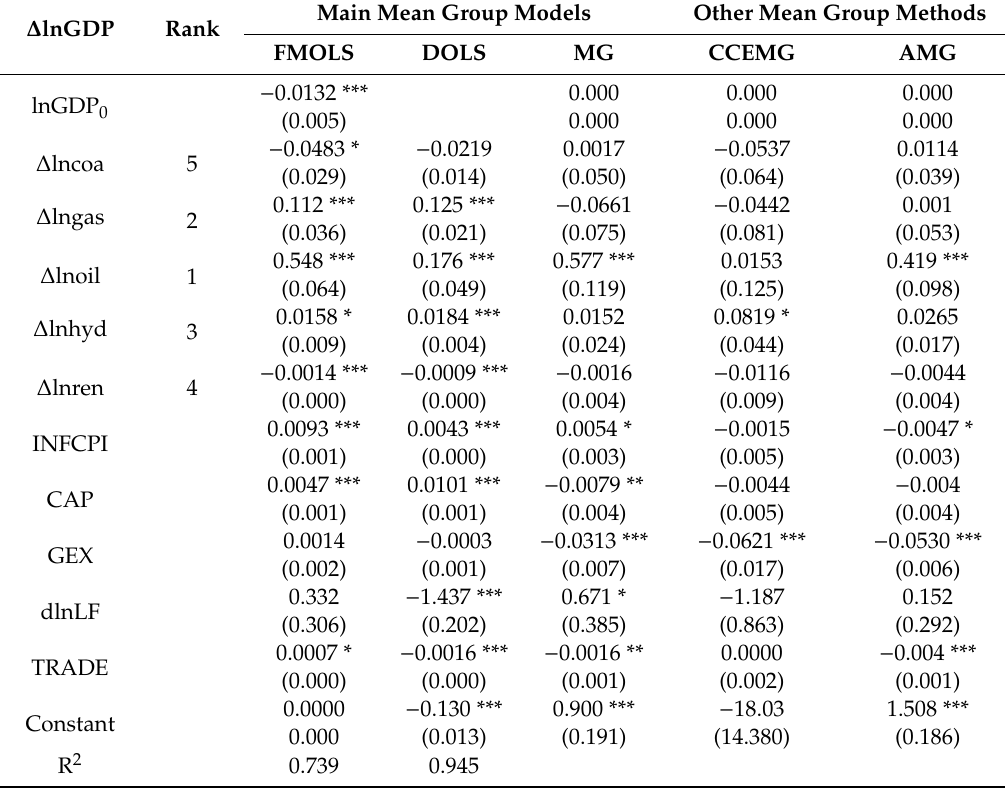
Table 9. Regression and ranking